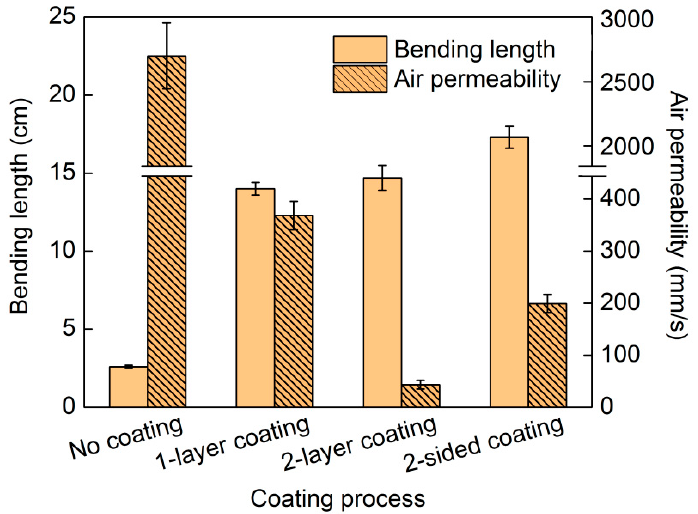
Figure 3. Bending length and air permeability of nonwoven and composites from various coating processes.